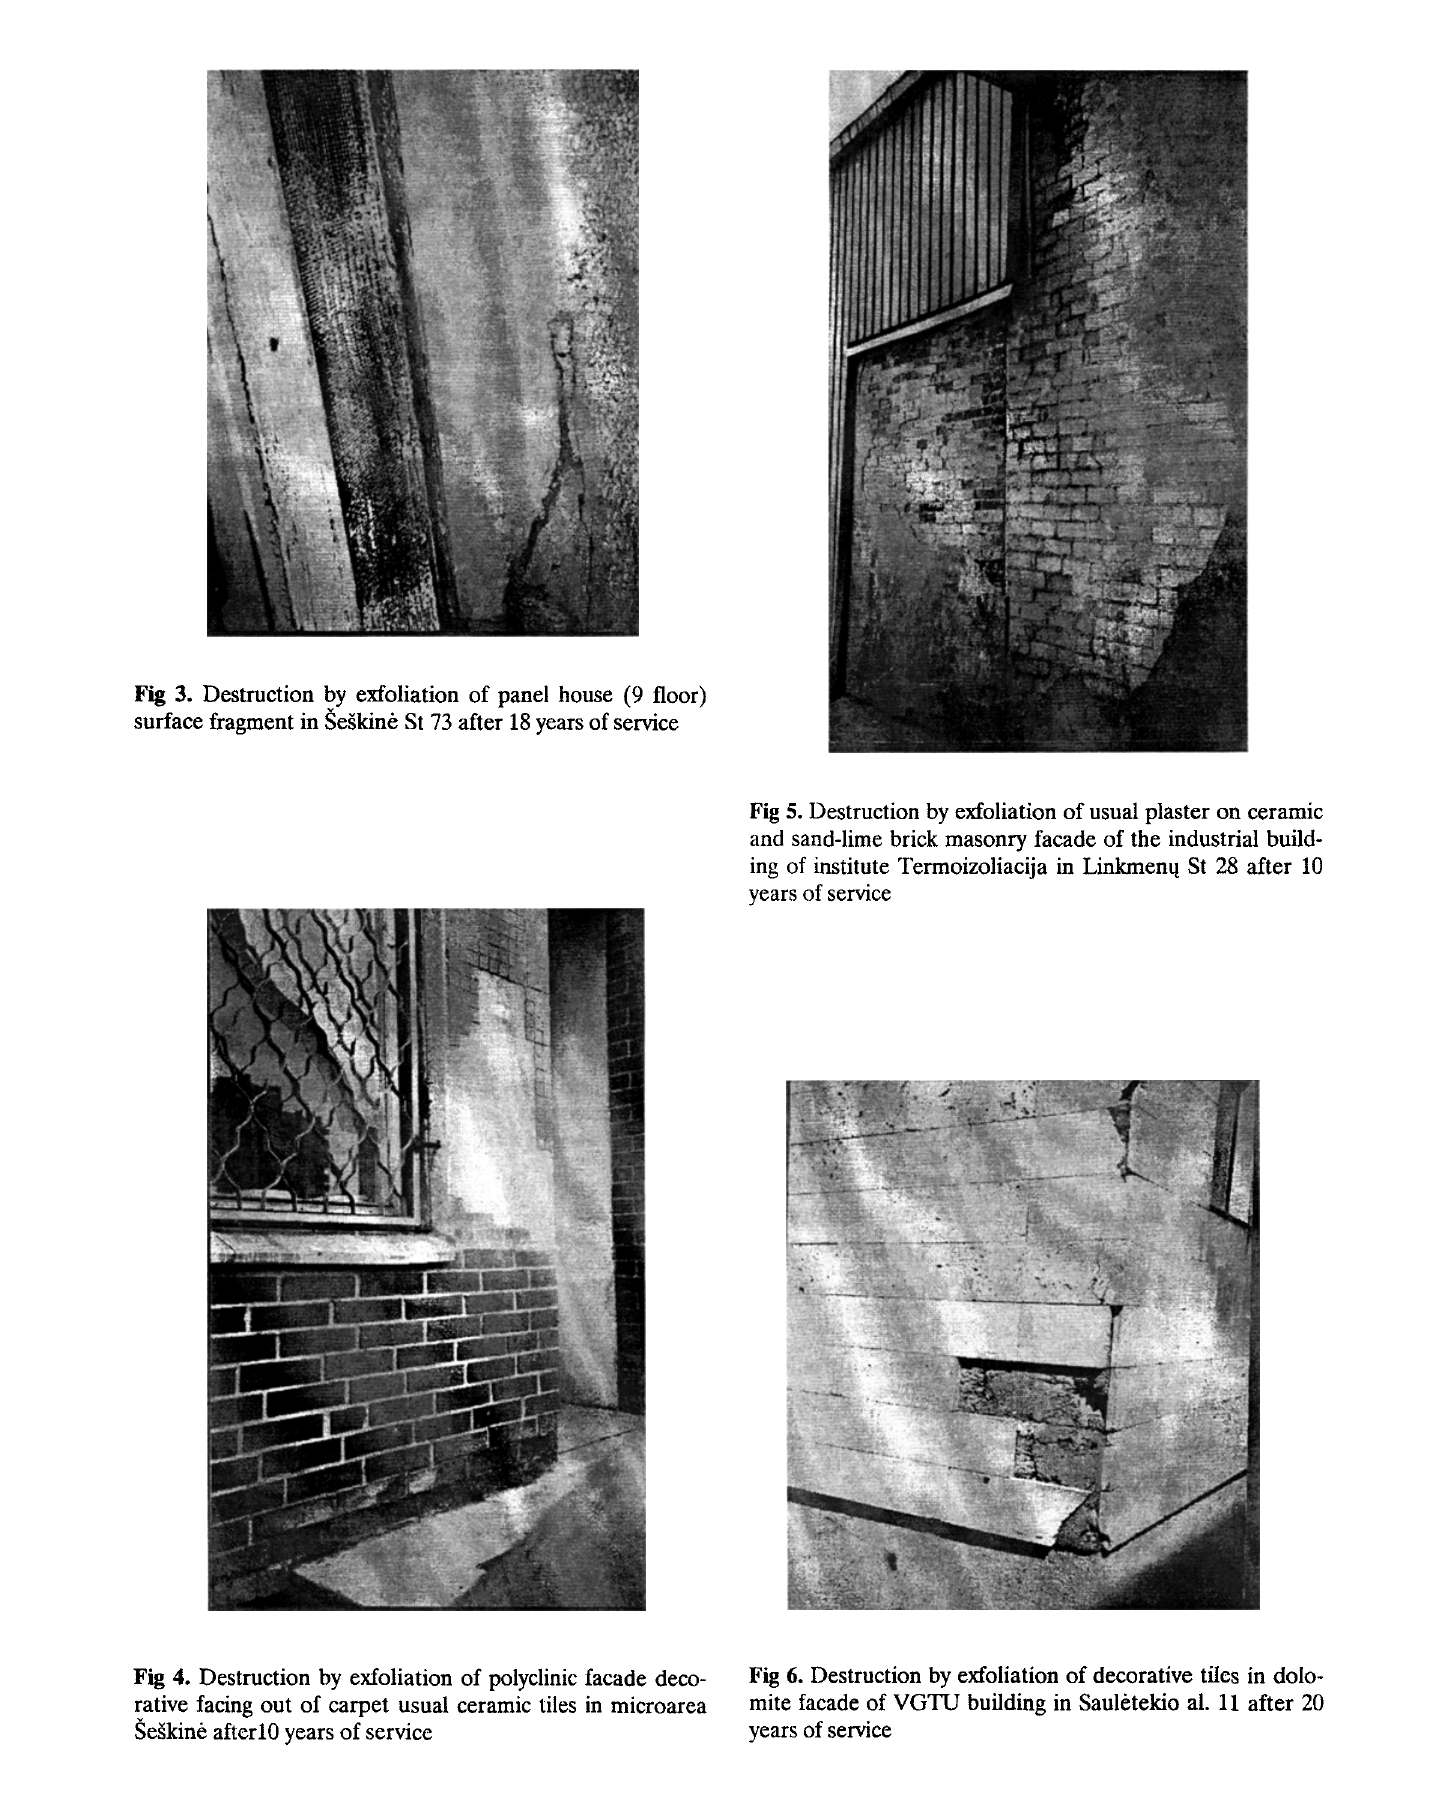
Fig 4. Destruction by exfoliation of polyclinic facade deco- Fig 6. Destruction by exfoliation of decorative tiles in dolo- rative facing out of carpet usual ceramic tiles in microarea mite facade of VGTU building in Sauletekio al. 11 after 20 ~ e ~ k i n e after10 years of